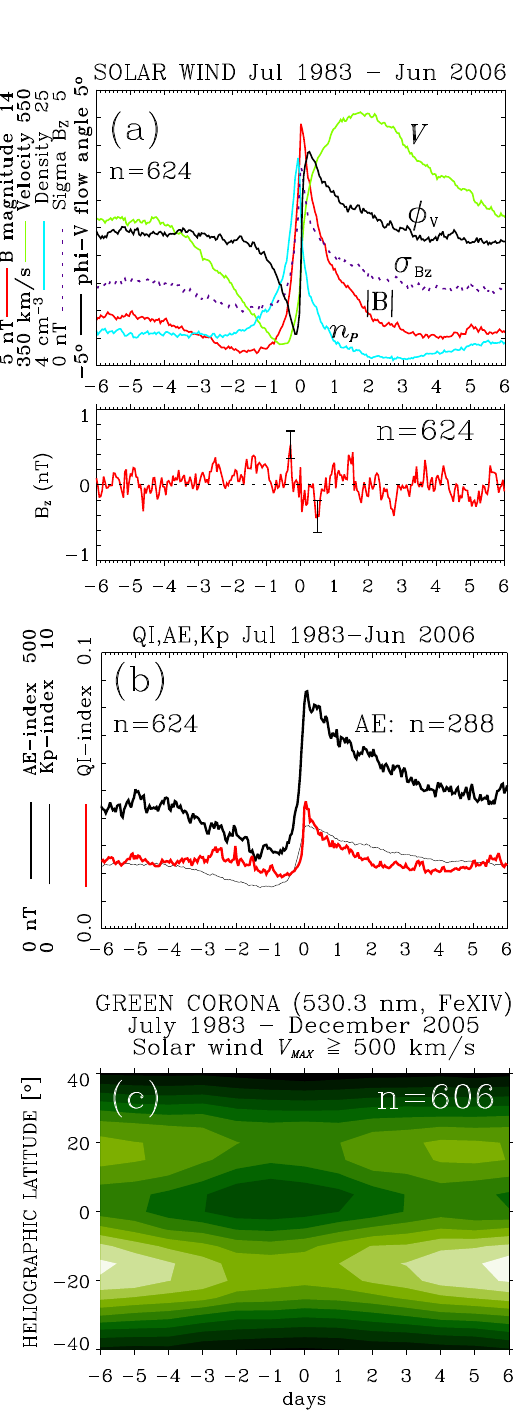
Fig. 10. Superposed epoch analysis of ( a ) solar wind plasma parameters V , n p , | B | , σ Bz , φ V and B Z , (b) QI, AE and K p indices, and (c) the green coronal emission line intensity interpolated for the central meridian. Darker color represents lower intensity and contours are 2 ACUs apart. All time series are keyed by the arrival time of streams/CIRs. The AE-index was only available for years 1983–1988 and 1990-1995.